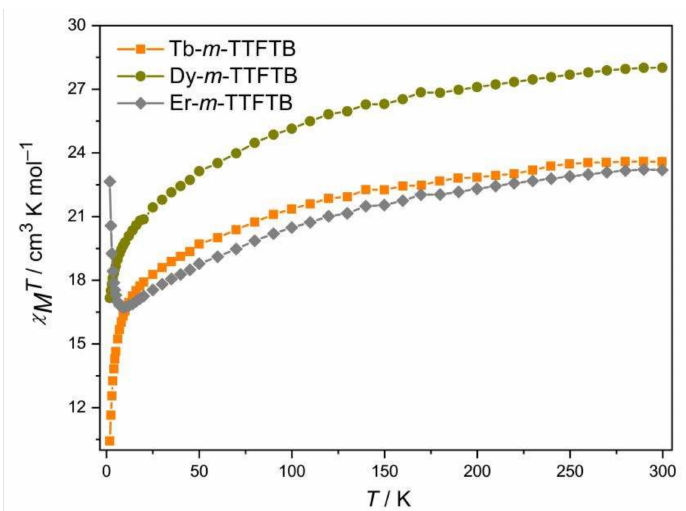
Figure 5. Temperature dependence of the χ M T measured in a 1000 Oe